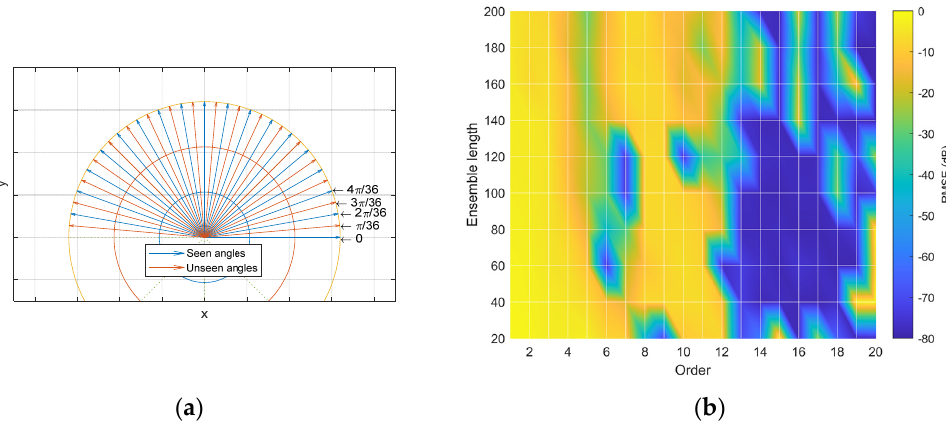
Figure 9. Incoming angles and RMSE distribution. ( a ) The angle distribution for learning is classified as seen angles (blue arrows) and the angles between the adjacent seen angles are organized as unseen angles (orange arrows). ( b ) One example of RMSE distribution in decibel scale for various orders and ensemble lengths.